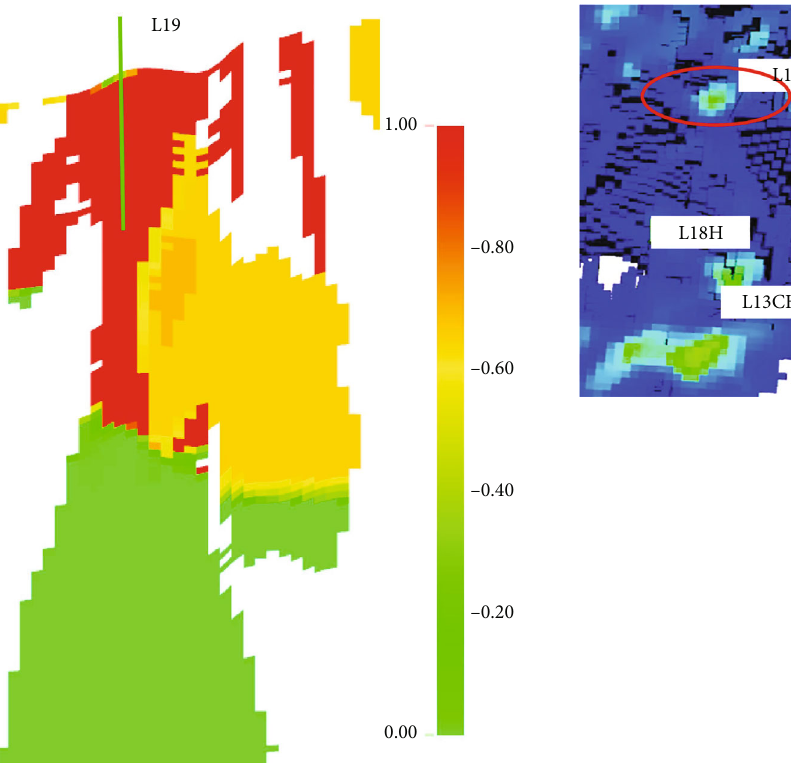
Figure 15: Residual oil near the L19